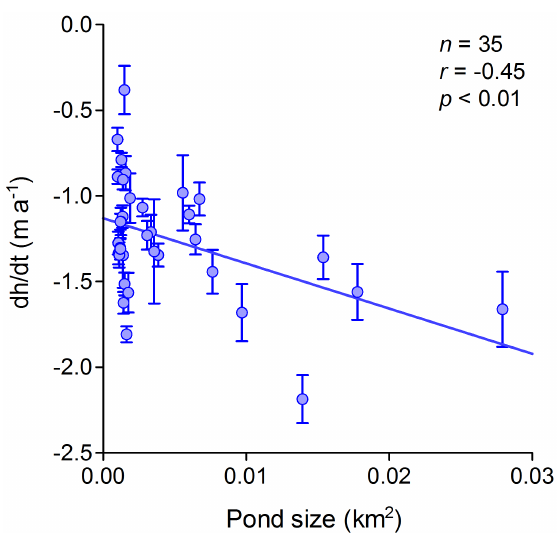
Figure 4. Rate of elevation change (d h/ d t ) of the supraglacial ponds observed on Kanchenjunga Glacier in